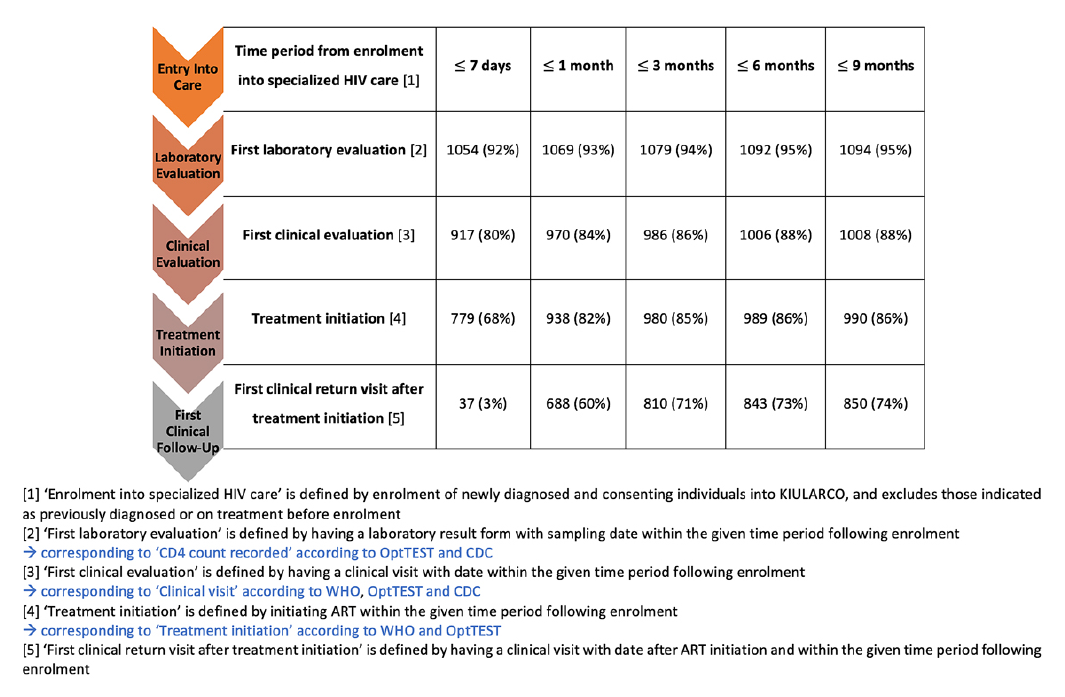
Figure 3: Steps of the “linkage to care” process in 1149 newly tested individuals enrolled into KIULARCO